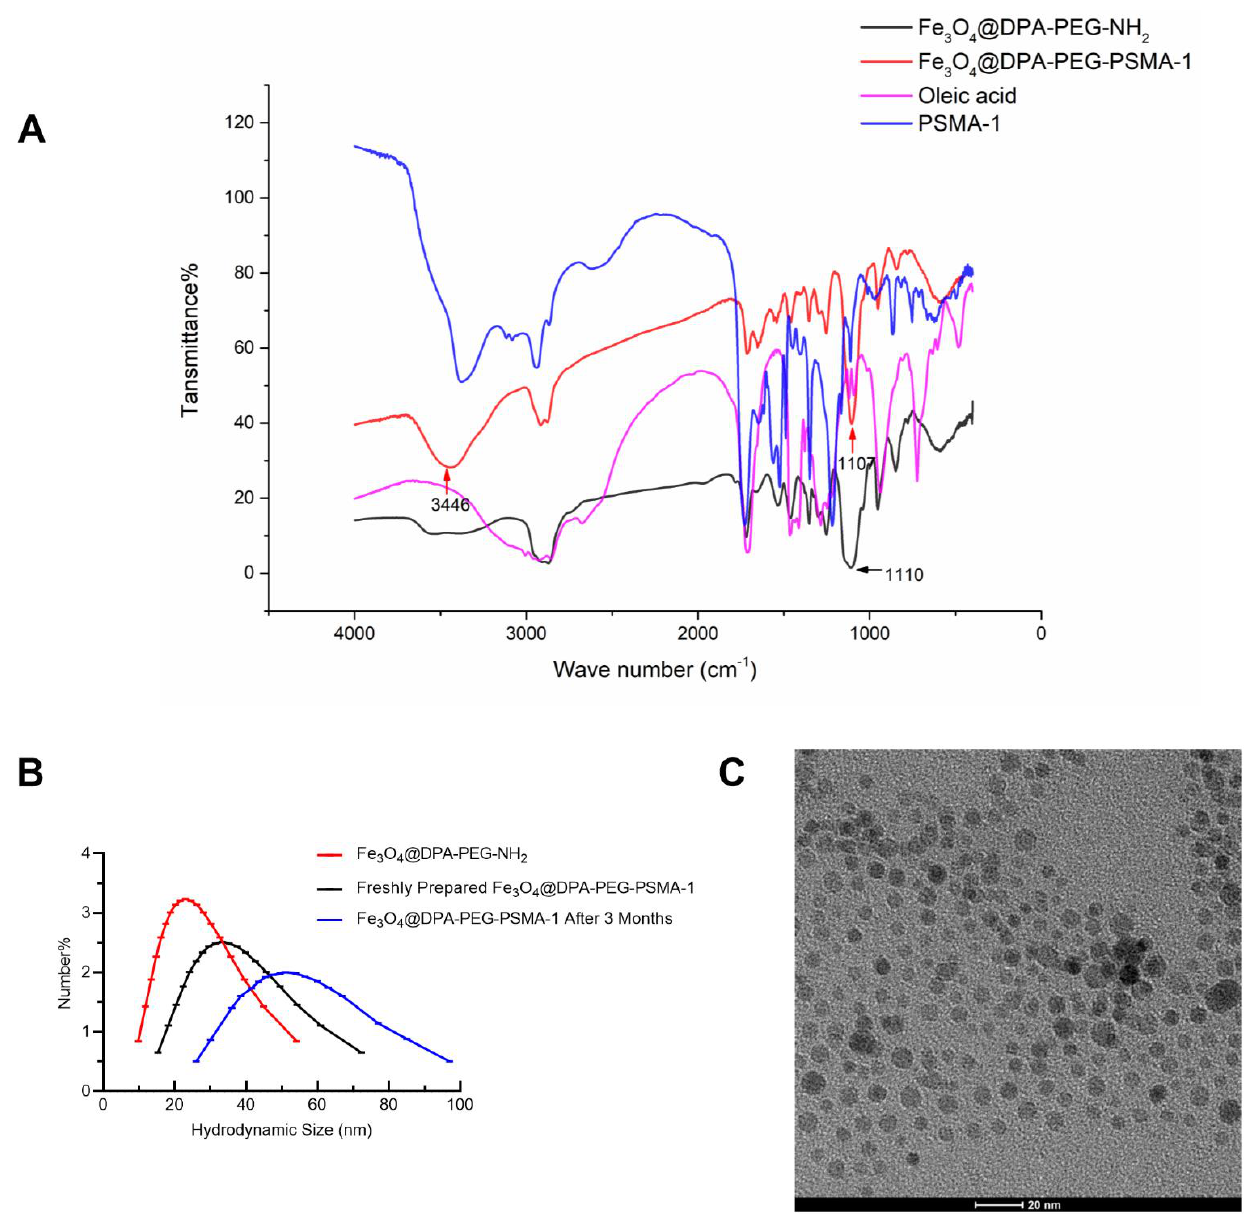
Figure 3. Characterization of Fe 3 O 4 @DPA-PEG-NH 2 and Fe 3 O 4 @DPA-PEG-PSMA-1. ( A ) FTIR spectra of Fe 3 O 4 @DPA-PEG-NH 2 (Black), Fe 3 O 4 @DPA-PEG-PSMA-1 (Red) PSMA-1 (Blue) and oleid